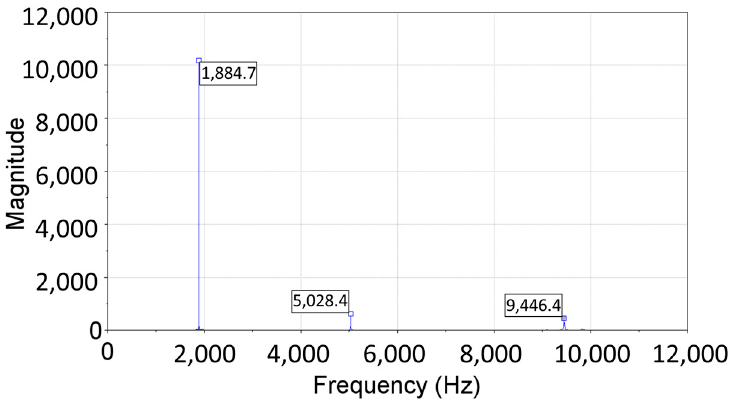
Figure 9. Frequency spectrum of recorded sound, S690 cylinder.